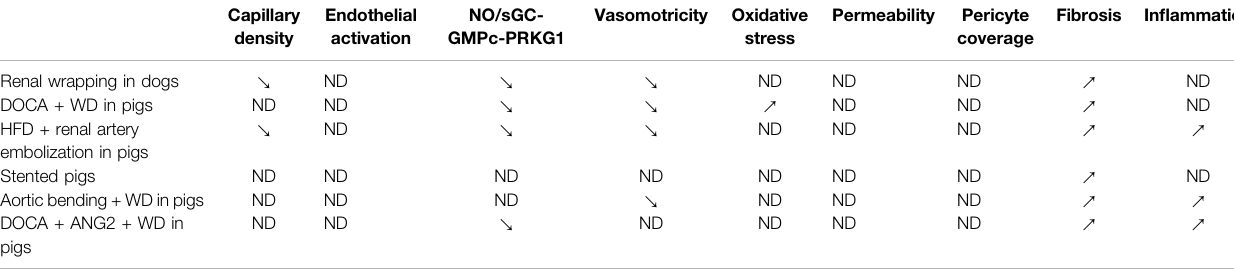
TABLE 4 | Microvascular characteristics of large HFpEF